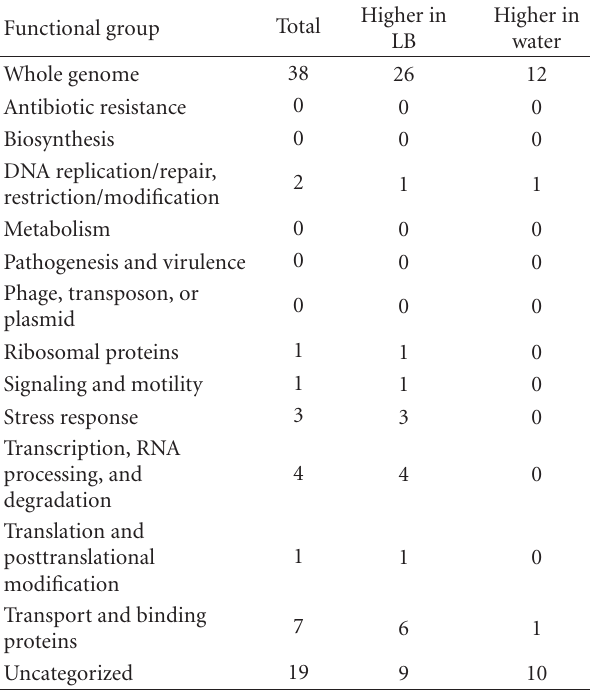
Table 2: Functional groups di ff erentially expressed between growth in LB and growth in sterile